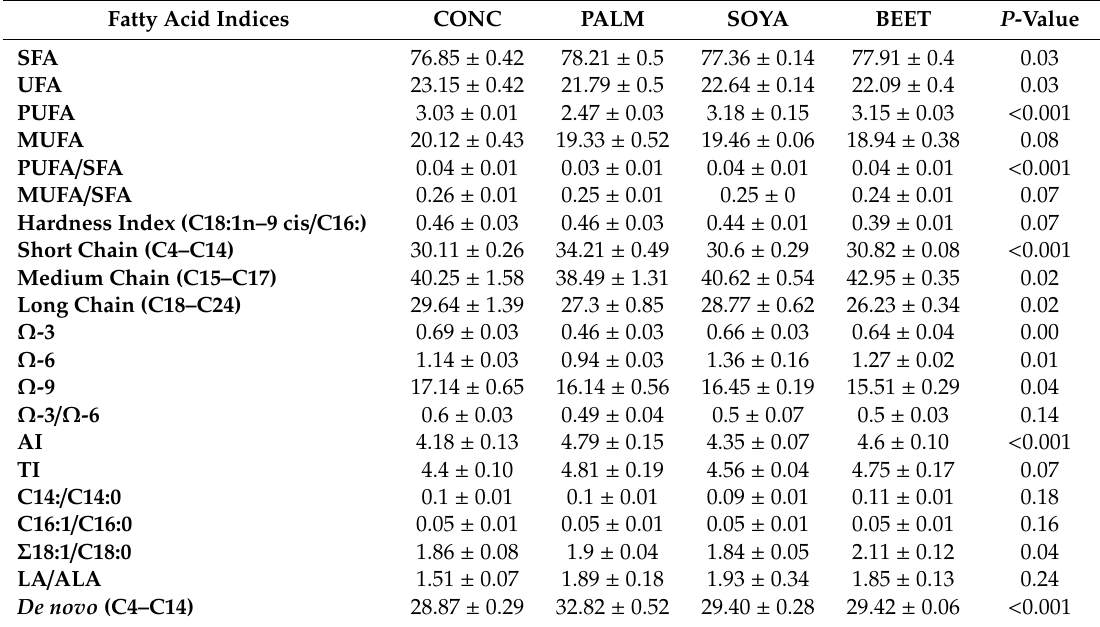
Table 8. Indices of fatty acid profiles from milks derived from cows fed a pasture diet supplemented with CONC, PALM, SOYA, or